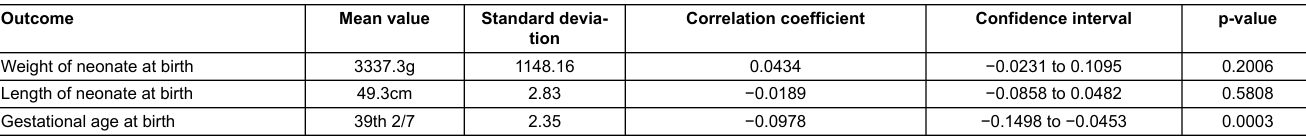
Table 5: Associations for numerical